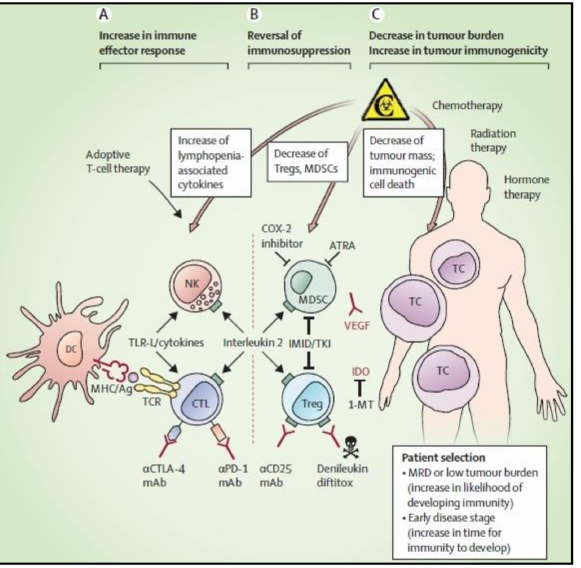
Figure 6. Multimodal techniques to enhance DC-based immunotherapy’s therapeutic effectiveness. DC-based cancer therapies aim to take use of DCs inherent ability to activate antitumor immune effector cells, such as natural killer cells and cytotoxic T lymphocytes that are specific to the tumor antigen. Dendritic cell therapy is being actively pursued in conjunction with therapeutic approaches that seek to strengthen the immune effector response ( A ), reverse cancer-associated immunosuppres- sion ( B ), or reduce the tumor burden and raise the immunological susceptibility of the tumor cells ( C ). Reproduced with permission from [92]. Copyright 2014,